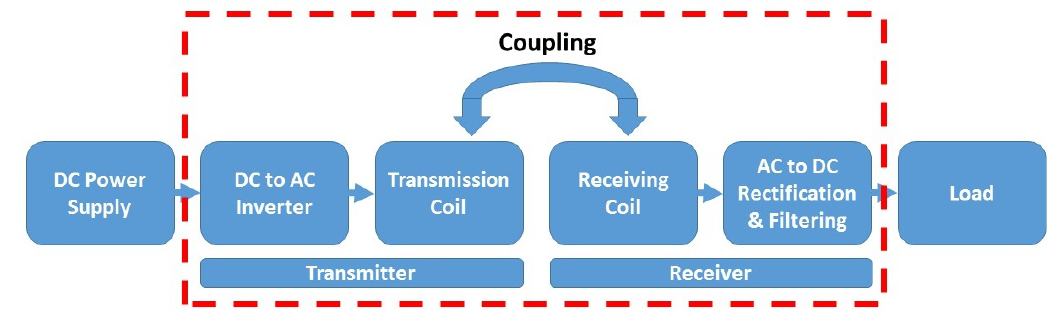
Figure 1. Typical block diagram for wireless power transfer.